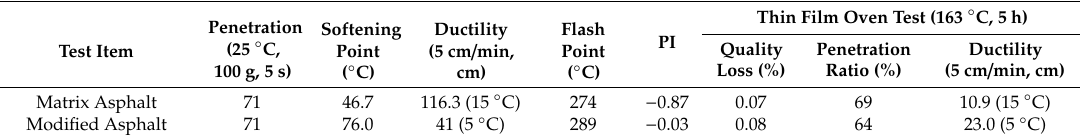
Table 1. Main technical indexes of asphalt.